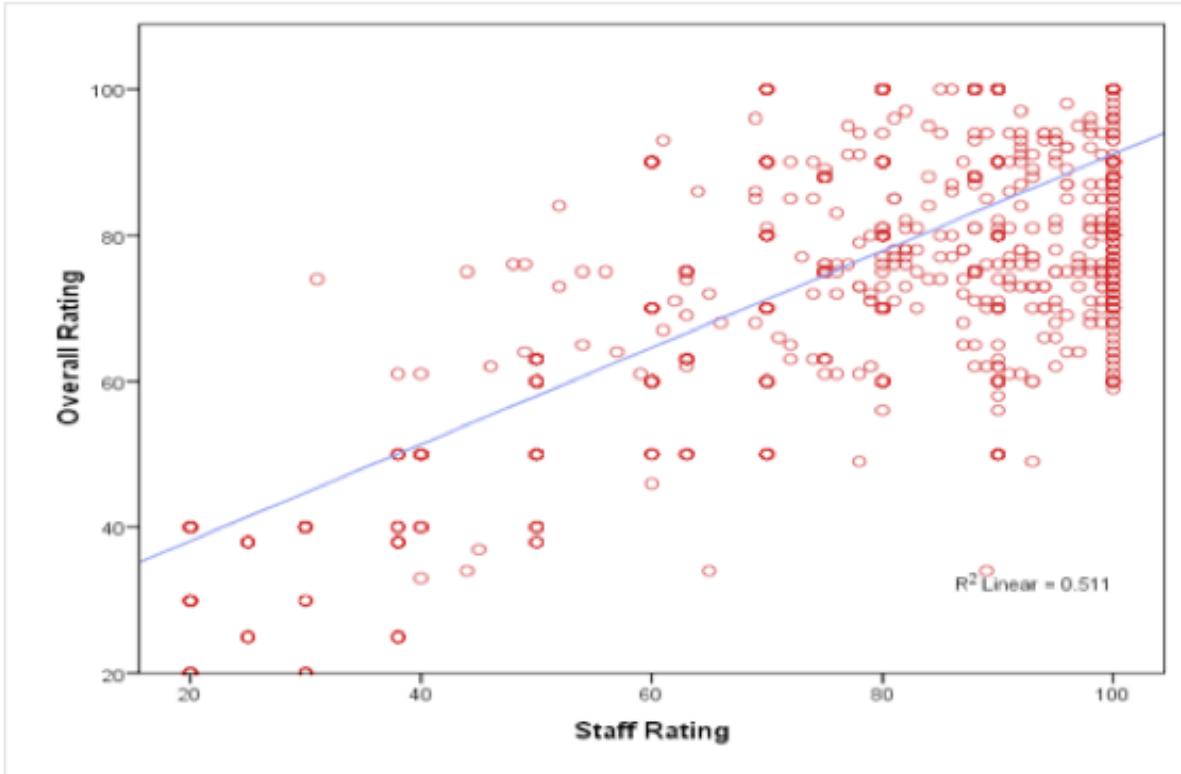
Figure 2. Pearson correlation comparing overall rating versus staff rating (n = 4999, Pearson correlation, r = .715, P <